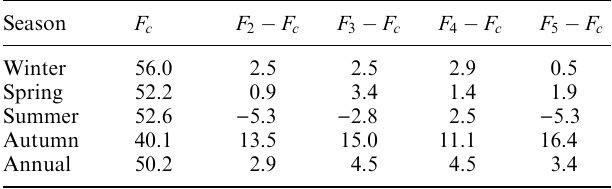
Table 2. Percentages in seasonal and annual averages of correctly computed signs of the anomalies of precipitation computed in the F c experiment, and compared to the results computed in the F 2 , F 3 , F 4 and F 5